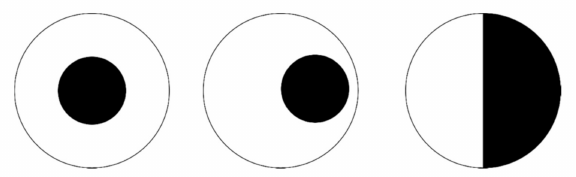
Figure 13. Examples of bicomponent fibre archetypes, from left to right: sheath core, eccentric sheath core and side by